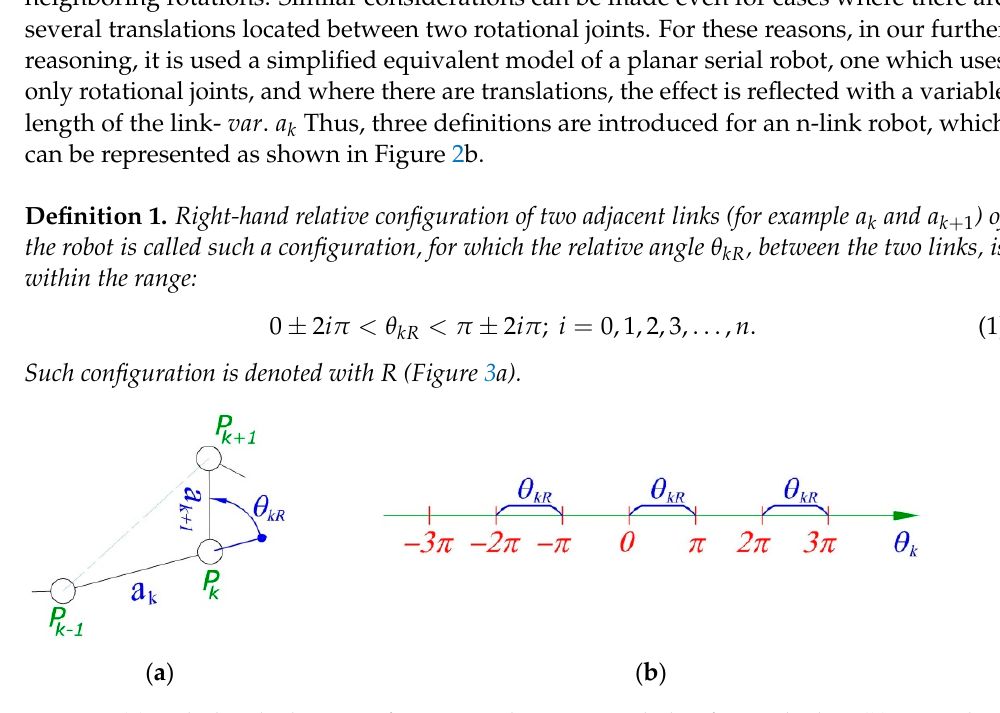
( b ) Figure 2. ( а ) Scheme of a planar serial robot with n rotational and translational degrees of freedom—